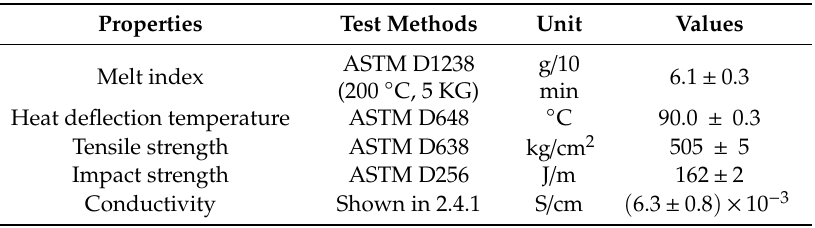
Table 1. Basic thermo–mechanical and electrical properties of the conductive acrylonitrile butadiene styrene (ABS)